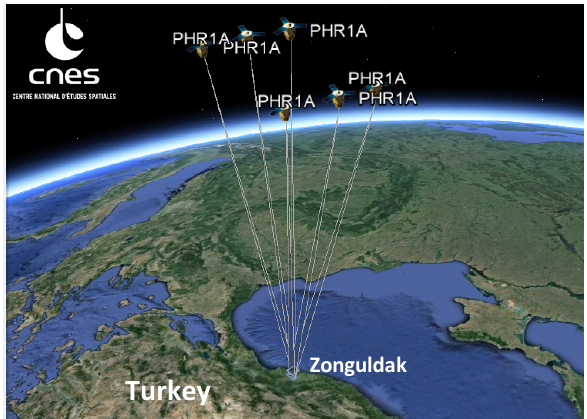
Figure 3. Image acquisition over Zonguldak test site (illustration at Google Earth).